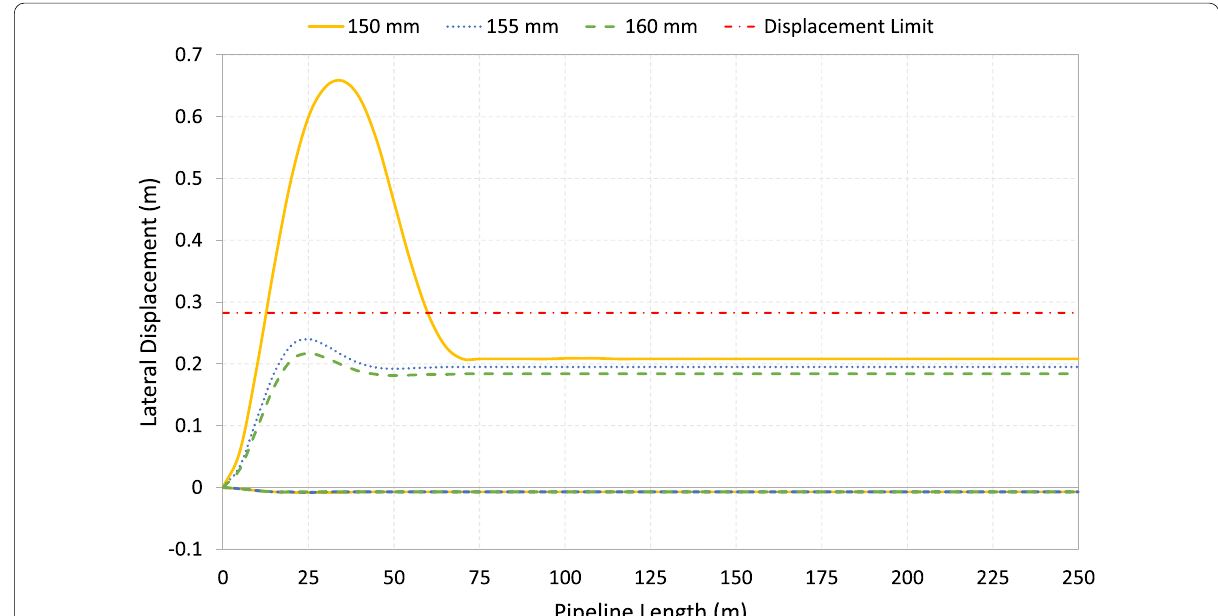
Fig. 5 Envelopes of the lateral displacements of the pipeline for concrete thickness range 150–160 mm (1-year RPV wave